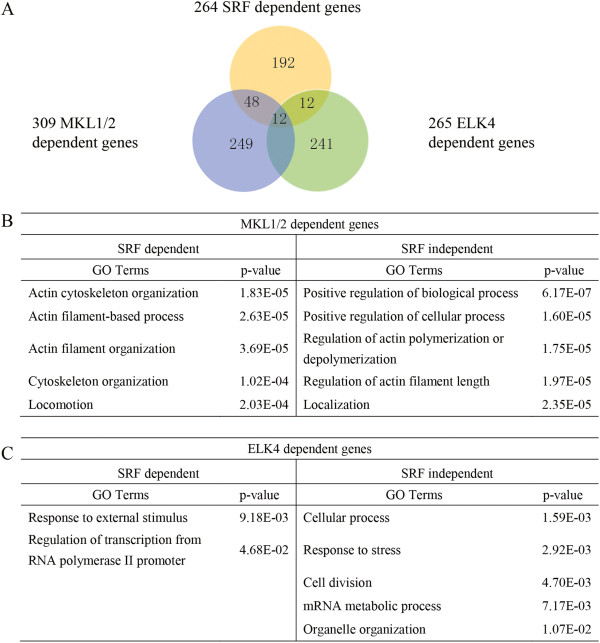
MKL1/2 and ELK4 regulate the transcription of different gene sets in zymosan induced macrophages. (A) Venn diagram indicating the relationships between SRF dependent genes with respect to MKL1/2 and ELK4 dependence. (B) Gene ontology analysis for biological process annotations of the SRF dependent or independent MKL1/2 target genes after zymosan treatment for 1 h. (C) Gene ontology analysis for biological process annotations of the SRF dependent or independent ELK4 target genes after zymosan treatment for 1 h.